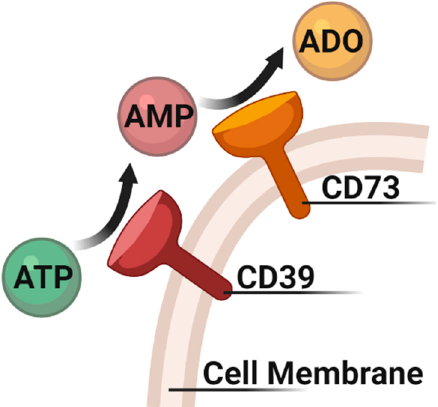
Figure 3. Adenosine metabolism pathway. Adenosine triphosphate (ATP) is degraded to adenosine monophosphate (AMP) by ectonucleoside triphosphate diphosphohydrolase-1 (CD39). AMP is then converted to adenosine (ADO) by 5’-Nucleotidase (NT5E/CD73). Both enzymes are expressed on the cell surface of numerous cells in the tumor microenvironment. This figure was made with biorender.com.